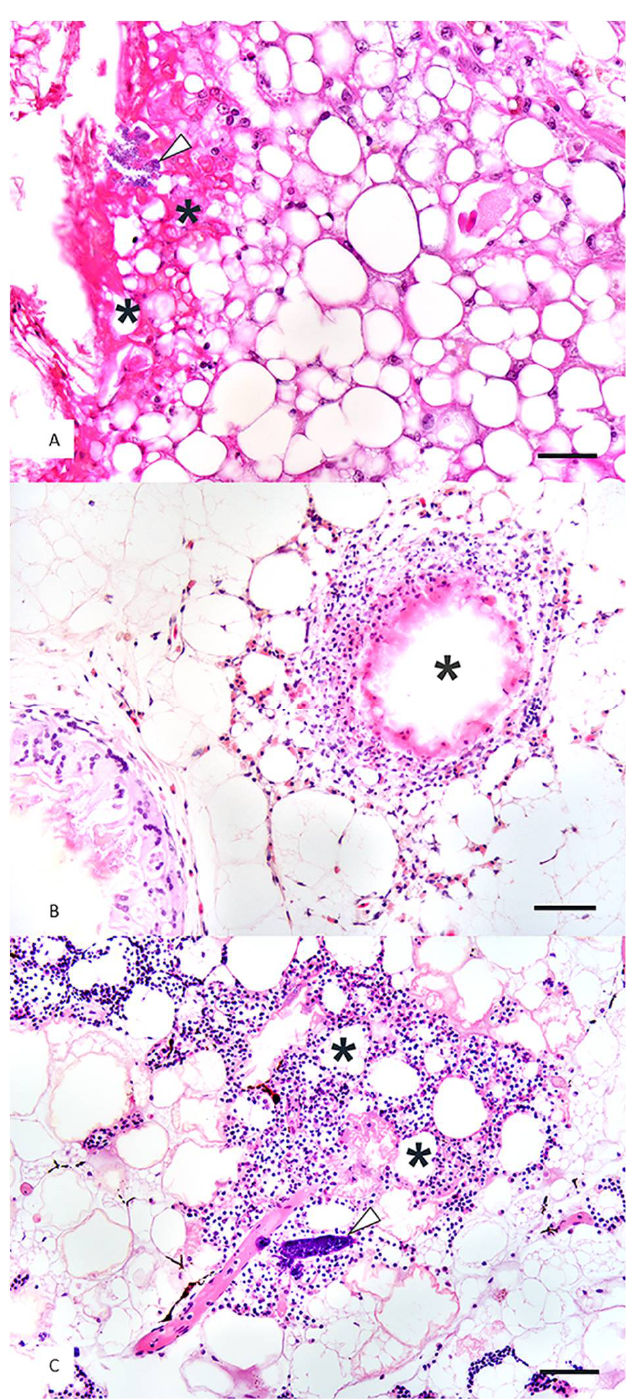
Figure 3. Tissue sections of fat from Kemp’s ridley sea turtles ( Lepidochelys kempii ) with steatitis. Hematoxylin and eosin. ( A ) A cluster of bacteria (arrowhead) is present within an area of necrotic fat and degenerate heterophils (asterisks). Hematoxylin and eosin. ×40 objective. Scale bar = 50 µm. ( B ) Heterophils and macrophages surround necrotic fat (asterisk). A more chronic area of steatitis is present in the lower left as a granuloma composed of multinucleated giant cells formed around ceroid. Hematoxylin and eosin. ×20 objective. Scale bar = 150 µm. ( C ) A bacterial embolus (arrowhead) is within an area of fat necrosis, hemorrhage, and heterophilic inflammation (asterisks). ×20 objective. Scale bar = 170 µm.